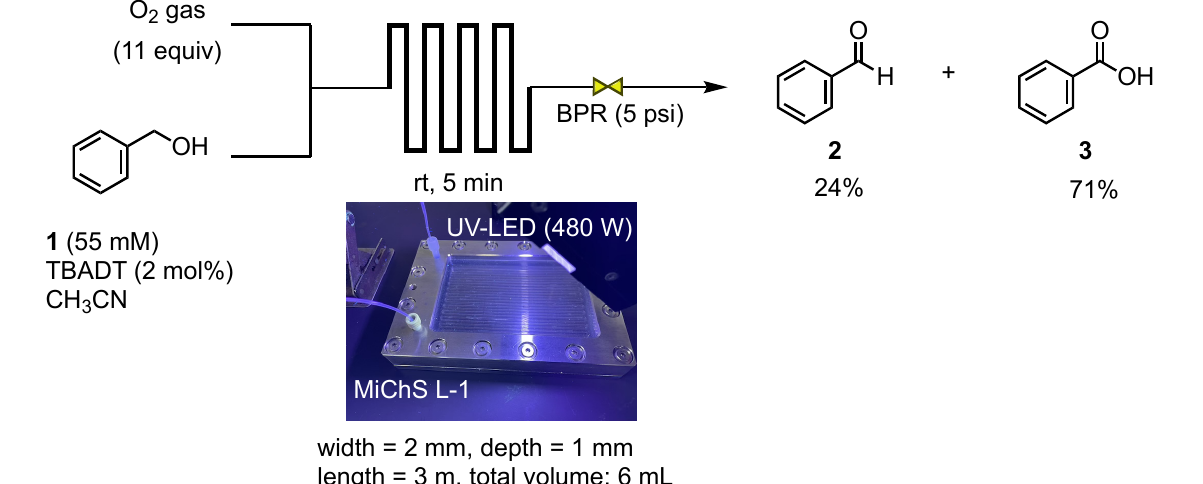
Figure 5. Time course for the oxidation of 1 to 2 and 3 via experiments using an NMR tube and irradiation by UV-LED at 480